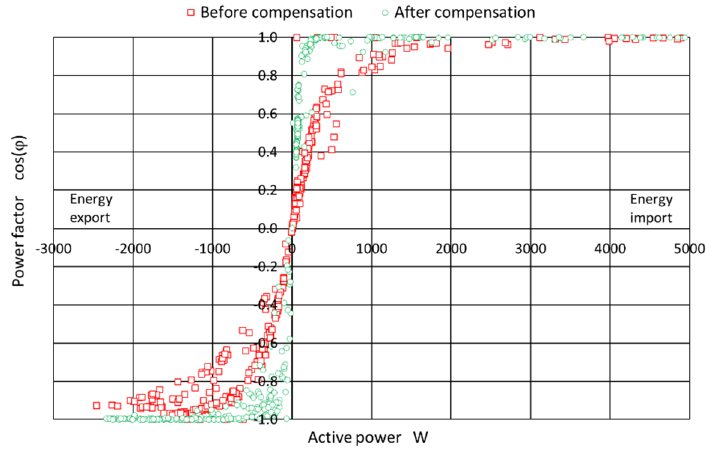
Figure 13. Power factor for imported and exported energy before and after capacitive reactive power compensation.